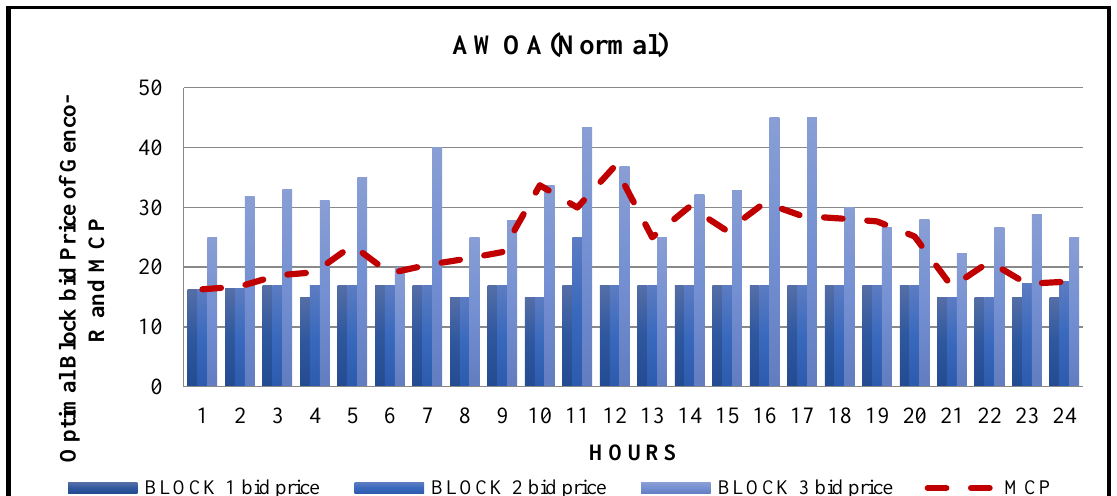
Table 9. Dispatch Obtained by Different Algorithms Using Normal Distribution for Genco-k.